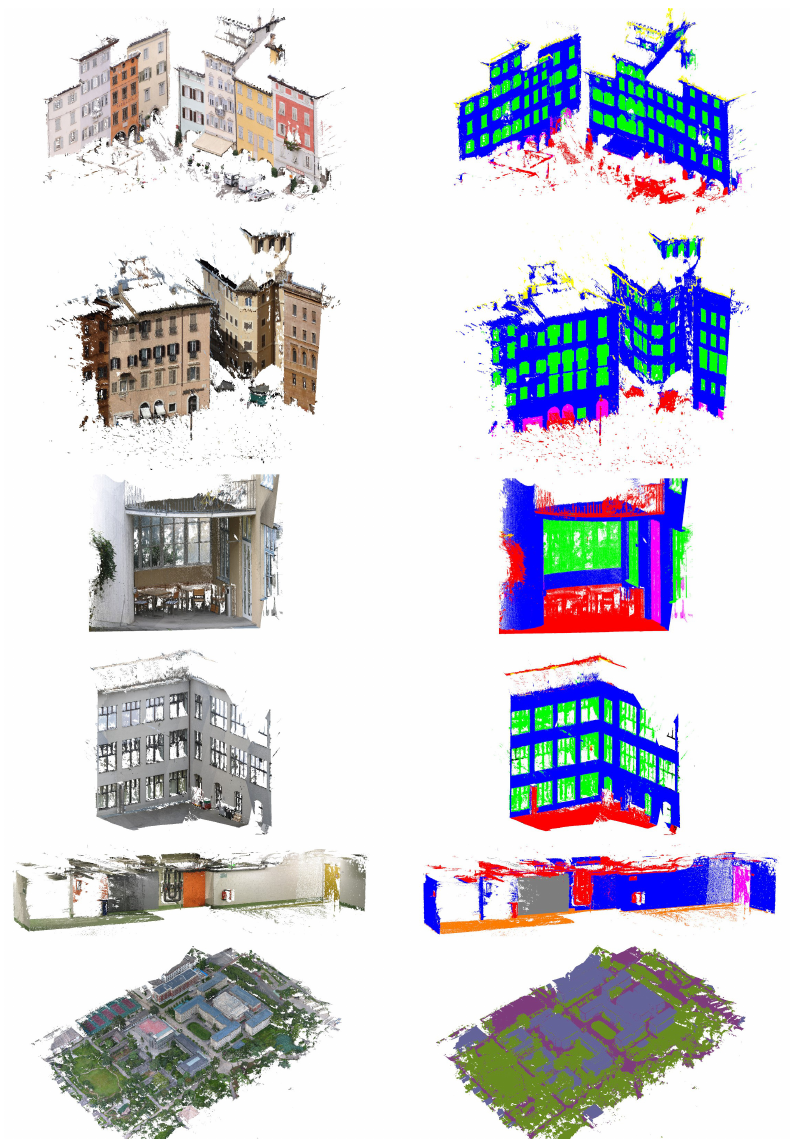
Figure 10. Dense point clouds generated by our method ( left ) and their semantically enriched equivalents ( right ). PiazzaDuomo , PiazzaNavona , ETH-terrace and ETH-courtyard follow the same class labels, namely “wall” ( blue ), “window” ( green ), “door” ( pink ), “other” ( red ). For the interior dataset ETH-pipes we set “wall” ( blue ), “floor” ( orange ), “closet” ( grey ), “door” ( pink ) and “other” ( red ). Aerial dataset UDD5 follows: “vegetation” ( green ), “building” ( purple ), “road” ( pink ), “vehicle” ( blue